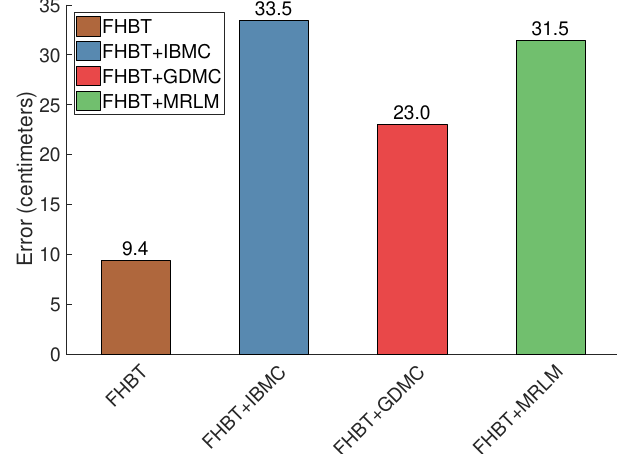
Figure 11. Worst case accuracy in centimeters (ratio of frames for which their maximum error is below a certain threshold).